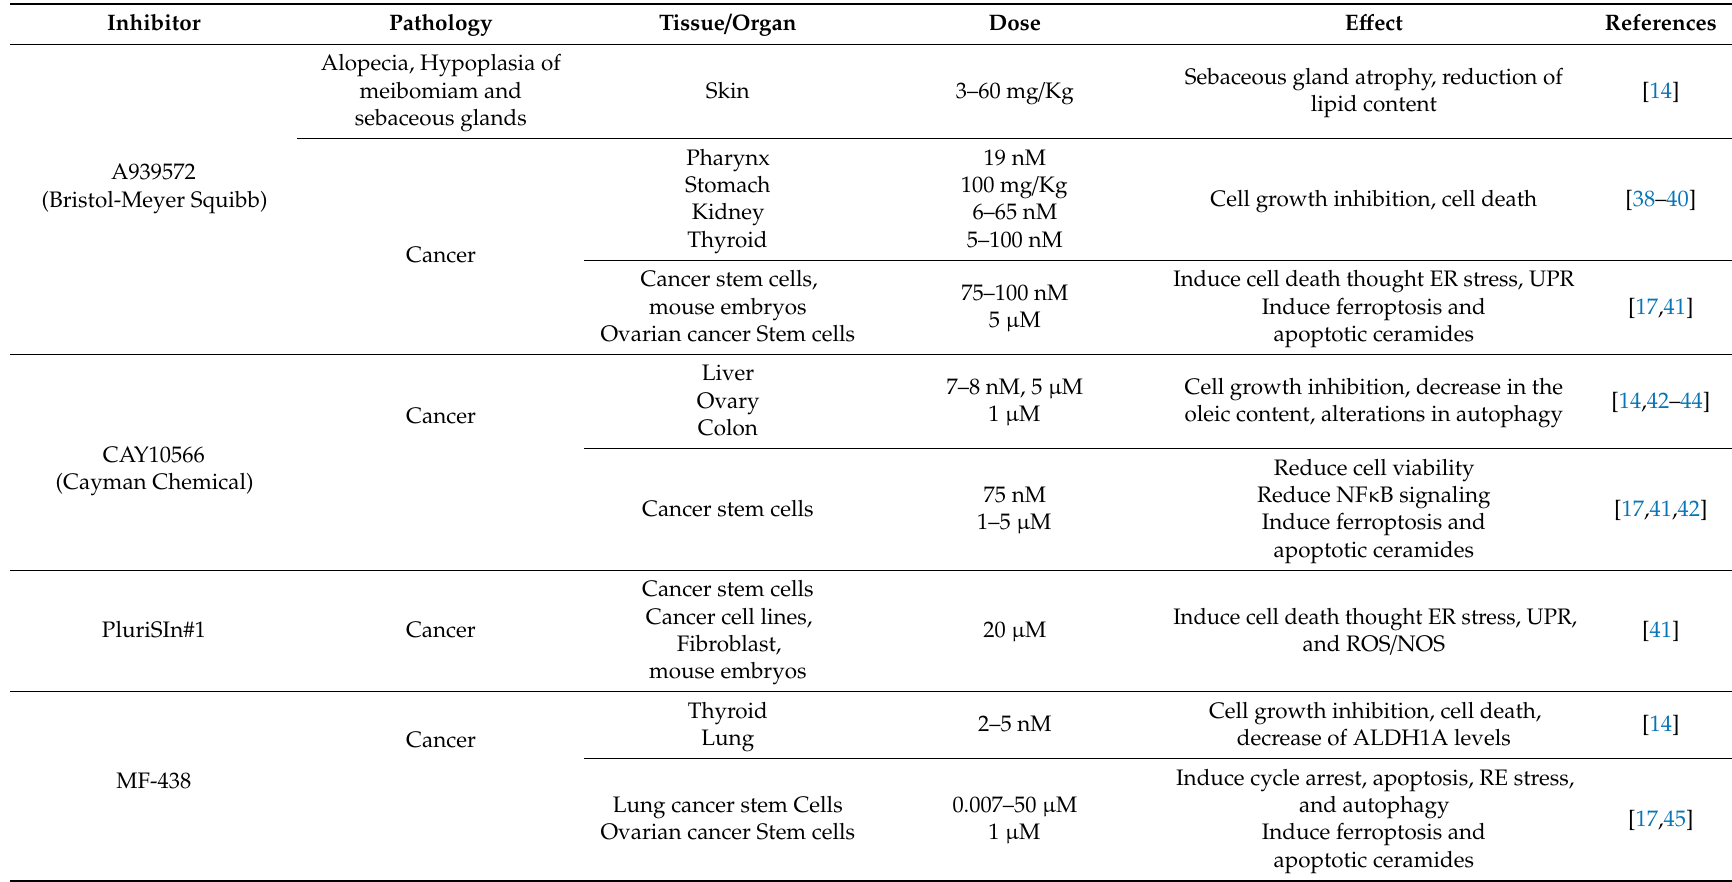
Table 1. SCD inhibitors used in the literature and related